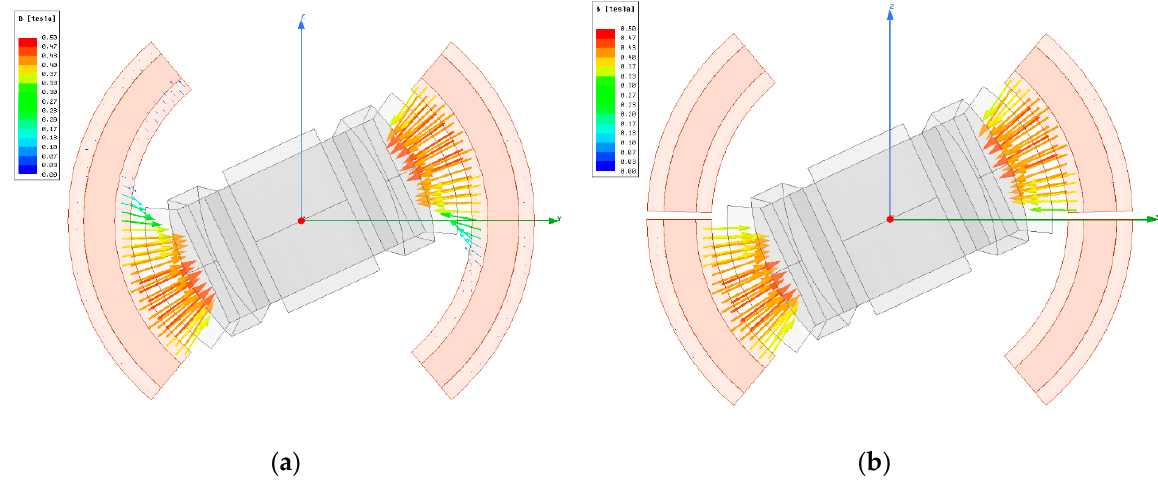
Figure 9. Magnetic flux density distribution of Y-Z cross-section when the rotor is rotating around the X -axis at 25 ◦ for ( a ) original and ( b ) proposed 3-DOF spherical motor,